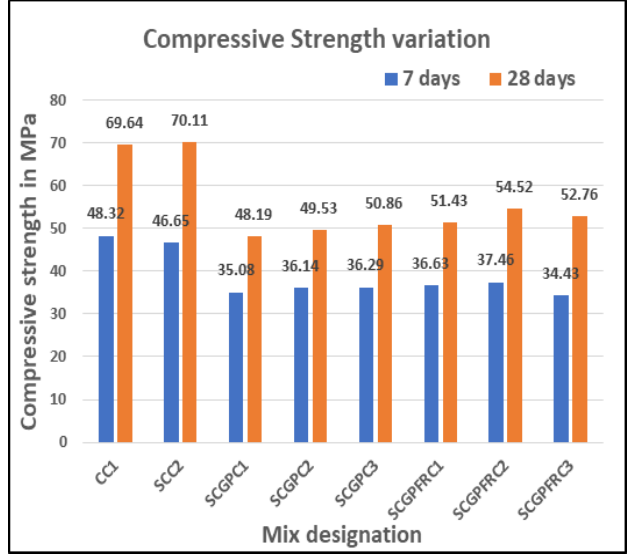
Fig. 11. Graph showing the variation of Compressive strengths for all